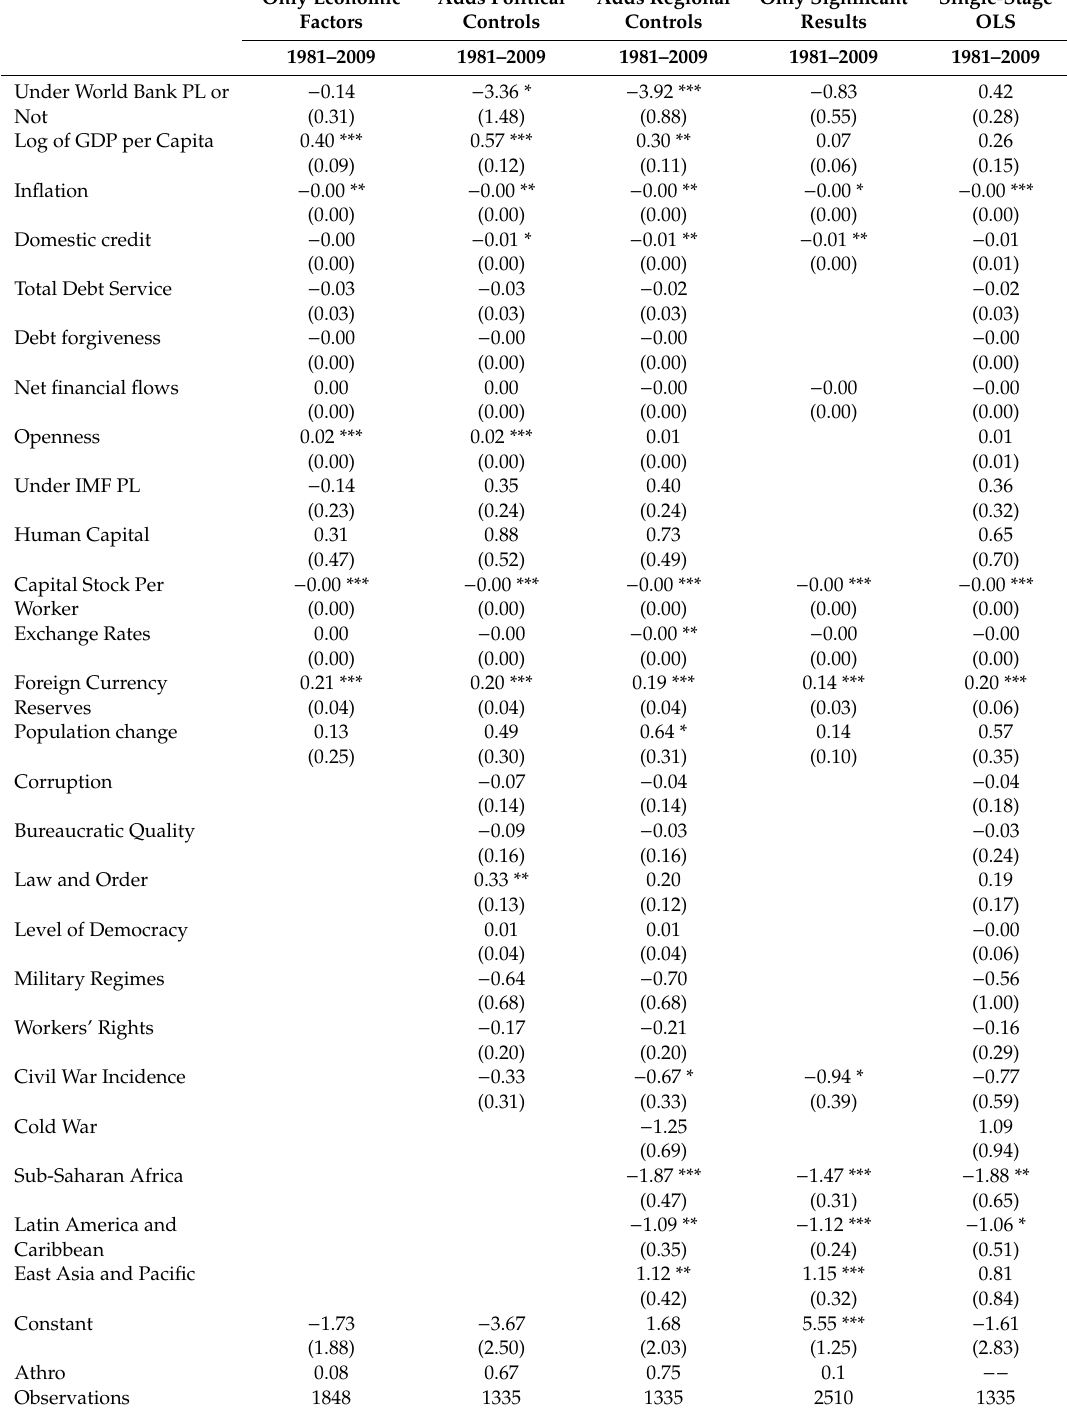
Table 3. Treatment Regression: World Bank Program Lending and Its E ff ects on Economic Growth, 1981–2009, All Developing Countries.